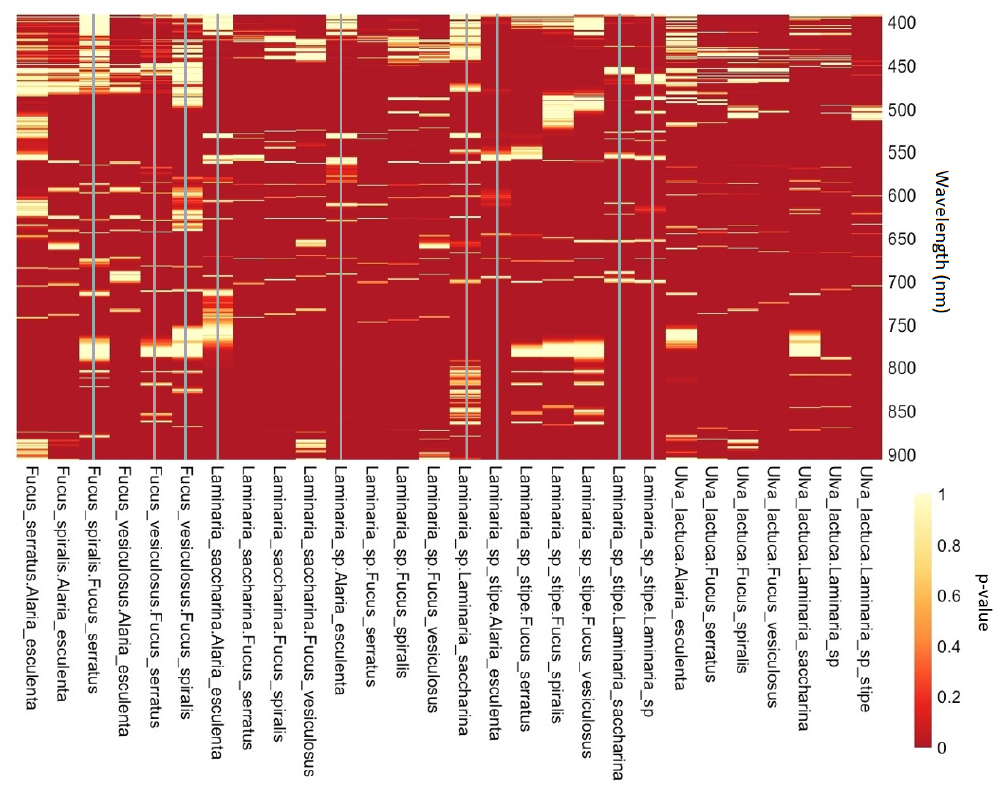
Figure 5. Heatmap of pairwise comparison p -values, intra-group comparisons represented by vertical bars. Legend depicting p -values with respect to heat